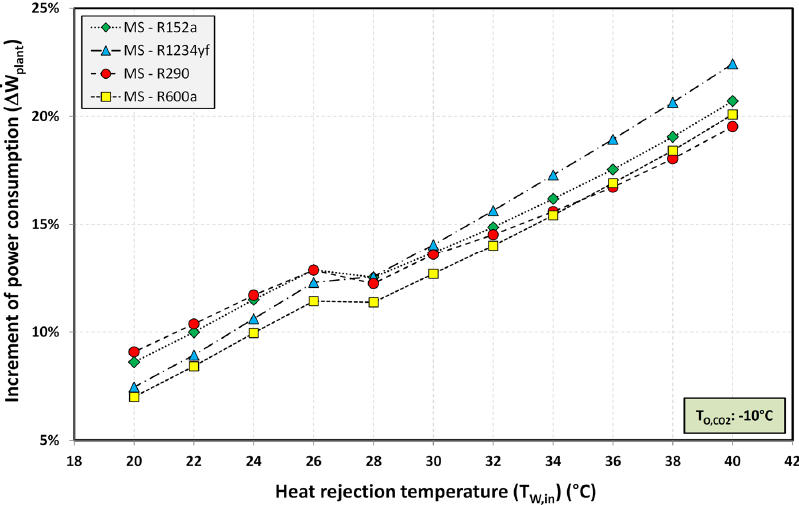
Figure 12. Increment of power consumption at the optimal operating conditions vs. heat rejection pressure.